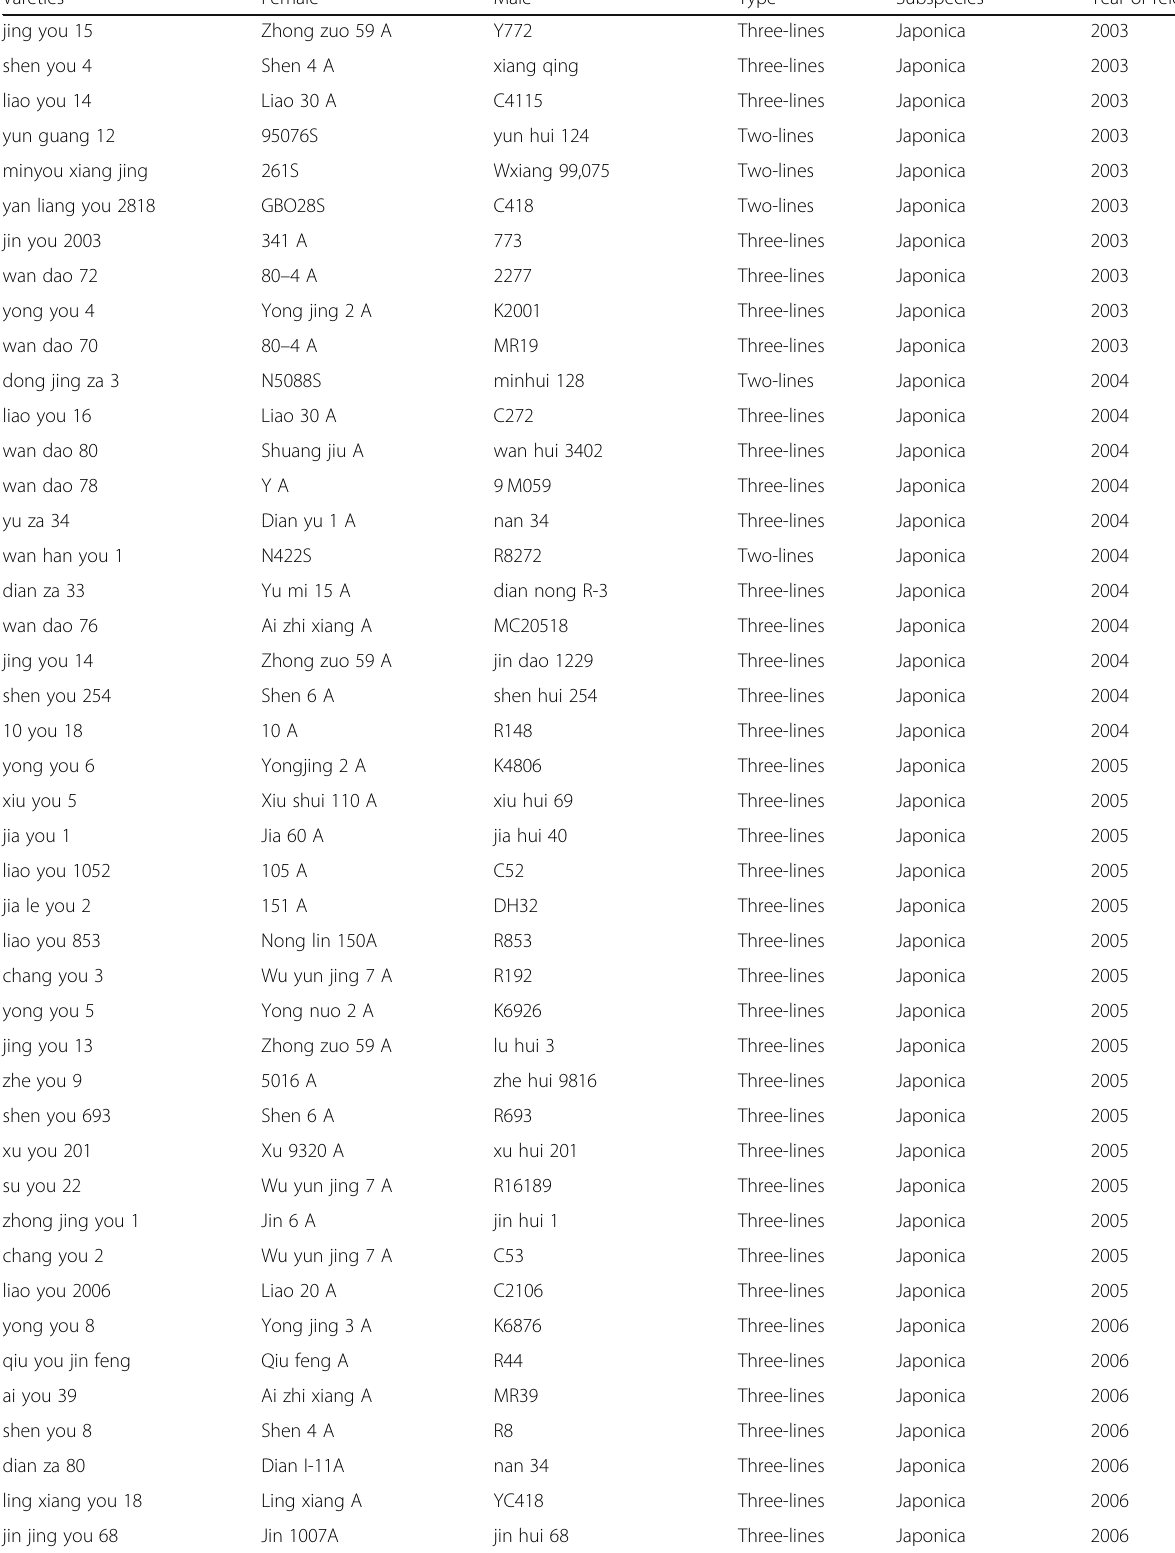
Table 1 List of hybrid japonica rice varieties bred in China (Continued)